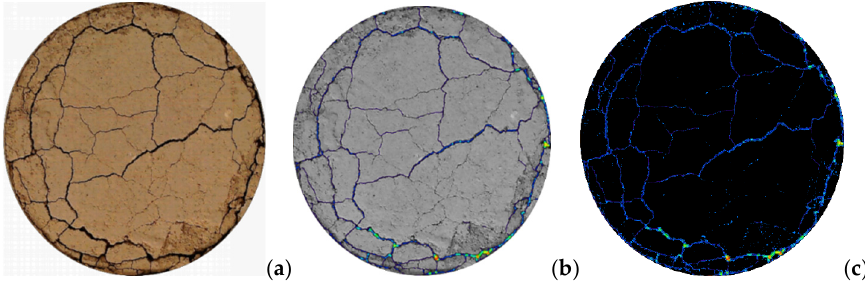
Figure 11. Fracture extraction process: ( a ) original image; ( b ) crack filling; ( c ) crack extraction.